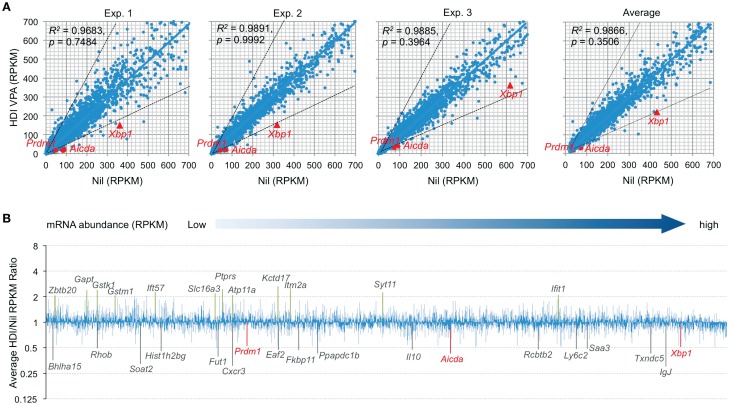
HDI selectively inhibits mRNA expression in B cells induced to undergo CSR and plasma cell differentiation. B cells were cultured with LPS plus IL-4 in the presence of HDI (VPA, 500 μM) or nil for 60 h before preparation of RNA for mRNA-Seq. (A) Scatter plots of average mRNA expression levels in three independent experiments (reads per kilobase per million mapped reads, RPKMs), in LPS plus IL-4-stimulated B cells treated with VPA versus those in LPS plus IL-4-stimulated B cells treated with nil. Each plot corresponds to one individual mRNA expression level. (B) Bar graphs depict the average folds of changes of mRNA expression levels (average RPKMs from three independent experiments) in LPS plus IL-4-stimulated B cells treated with HDI, as compared to those in B cells treated with nil. Only the mRNAs at average RPKM >20 in LPS plus IL-4-stimulated B cells treated with nil are included. Aicda, Prdm1, and Xbp1 mRNAs and the mRNAs that were increase or decreased or increased in average by more than twofold are indicated. p values, paired t-test.